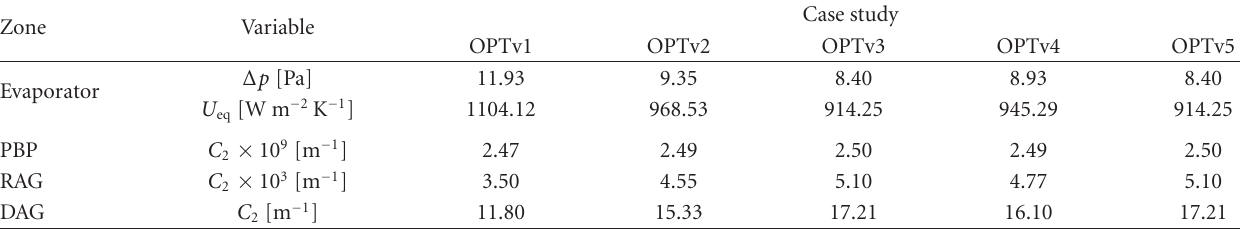
Table 3: Parameters specified at the evaporator, DAG, RAG, and PBP boundary conditions—OPTv case study. Zone